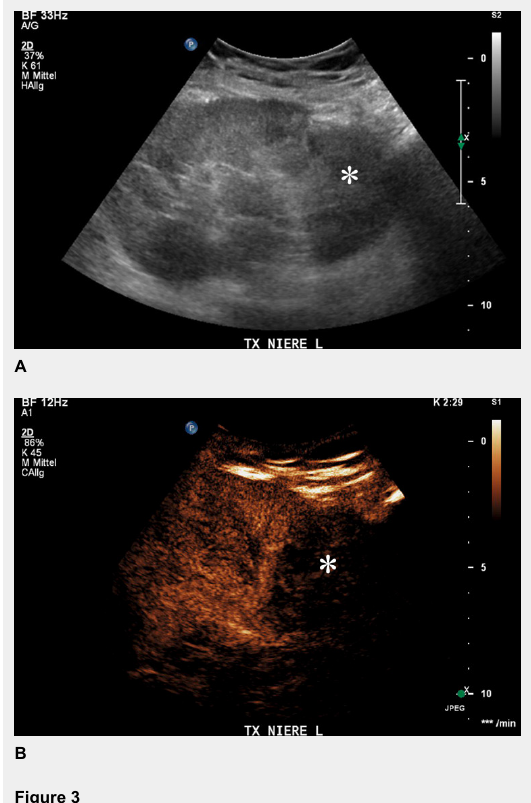
Transplanted kidney with hypoechoic region at the lower pole (*) on B-mode ultrasound (A). Corresponding CEUS imaging with devascularised region at the lower pole (*) in the transplanted kidney